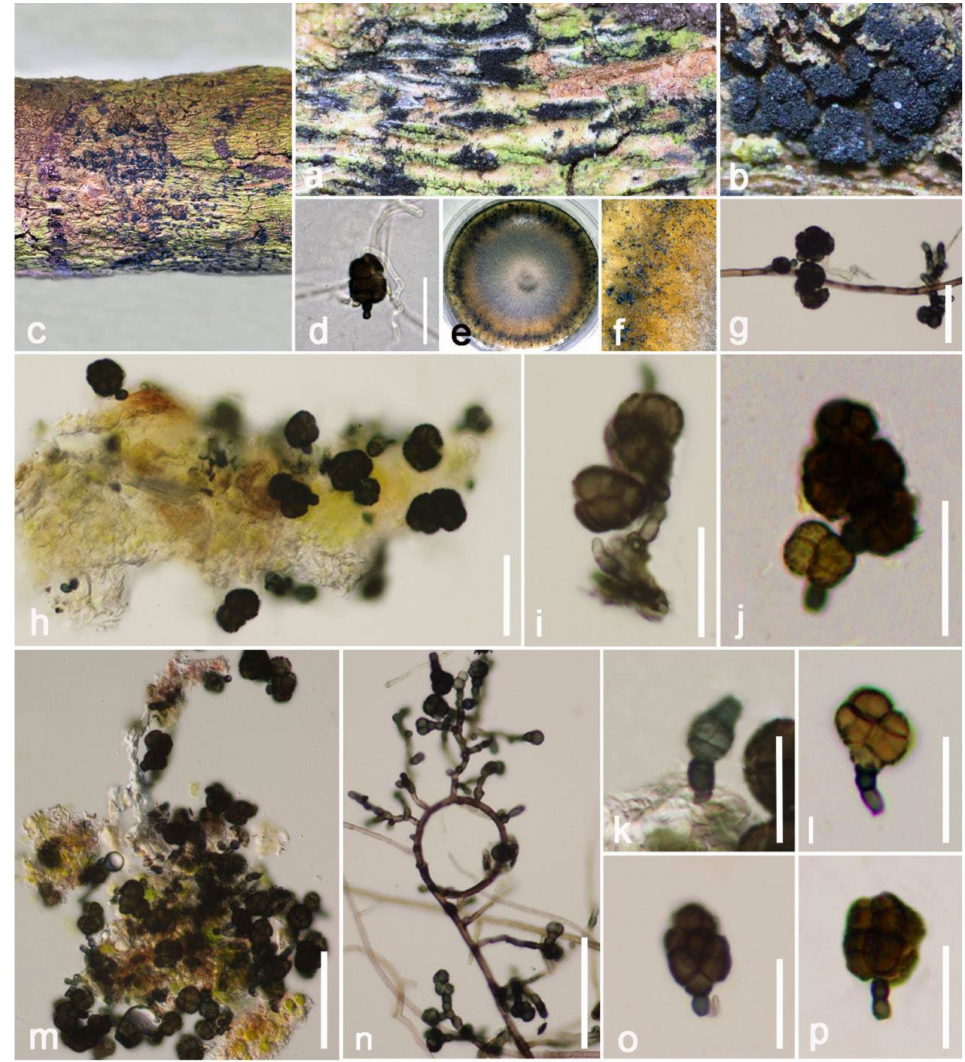
Figure 12. Paradictyoarthrinium diffractum (HKAS 122194). ( a – c ) Colonies on host; ( d ) germinating conidia; ( e ) above colony on PDA; ( f ) close-up of colony on PDA; ( g , n ) conidium with hypha from PDA; ( i – k ) conidia connected conidiogenous cells; ( h , m ) close-up conidia raised on host